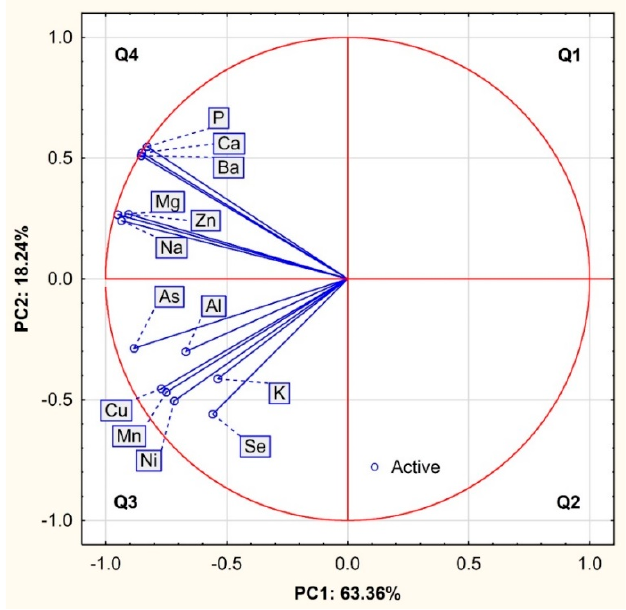
Figure 1. Projection of variables (bulk, trace and toxic elements) in a two-factor plane (PC1 × PC2).